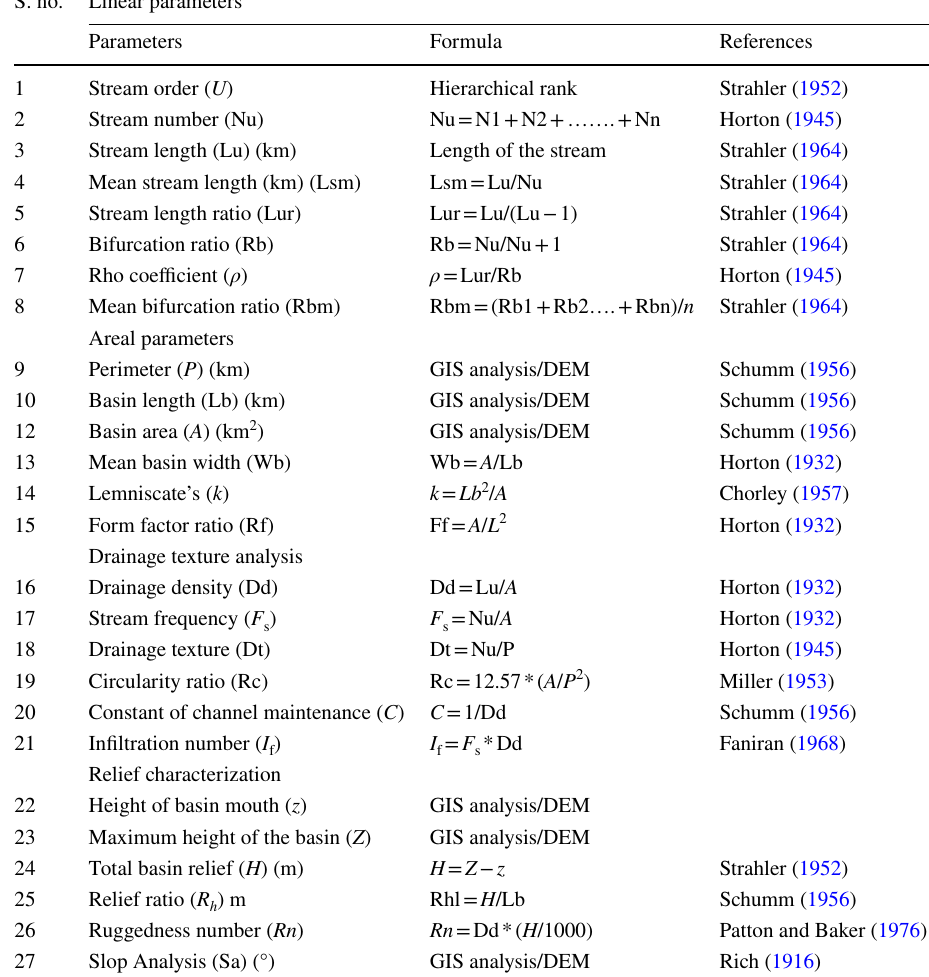
Table 2 Methodology adopted for computation of morphometric